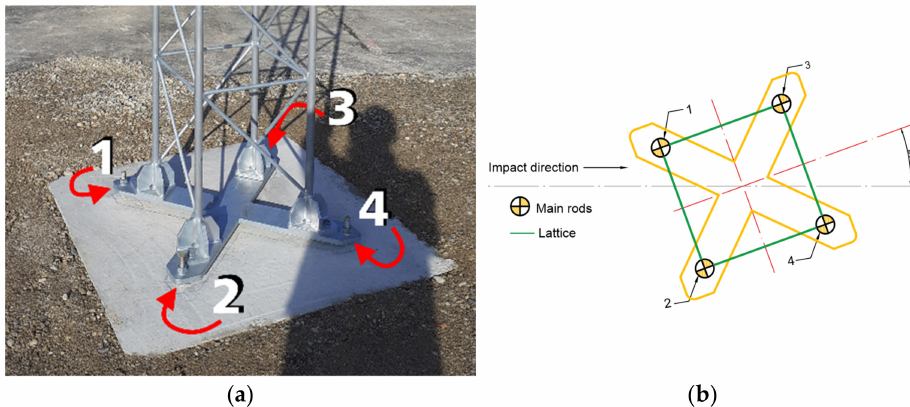
Figure 8. Safety joints breaking pattern: ( a ) mast T03, ( b ) pattern.